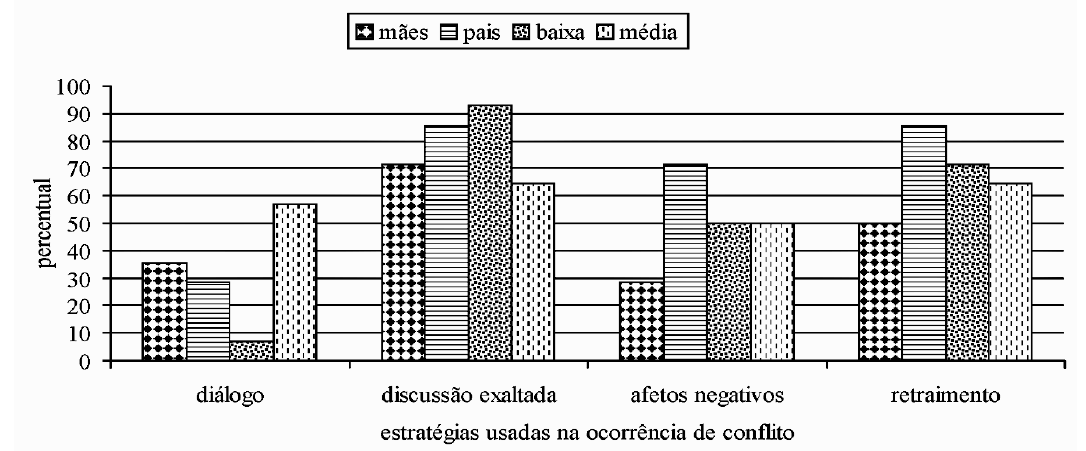
Figura 5. Rea(cid:231)ıes dos c(cid:244)njuges durante o conflito conjugal, segundo o relato de mªes e pais de classes baixa e